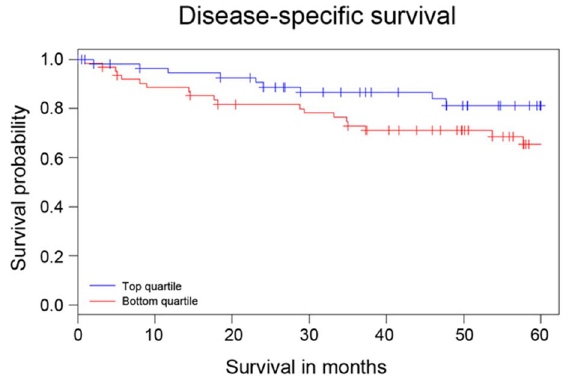
Figure 4. Patients with highest NEDD4L expression show a trend towards longer disease-specific survival compared to those with the lowest. Disease-specific survival in CRC patients with the highest and lowest NEDD4L expression was compared using Kaplan-Meier analysis. Those patients with tumor samples in the highest quartile of NEDD4L expression showed a trend towards longer disease-specific survival over a 60-month period. p=0.079.